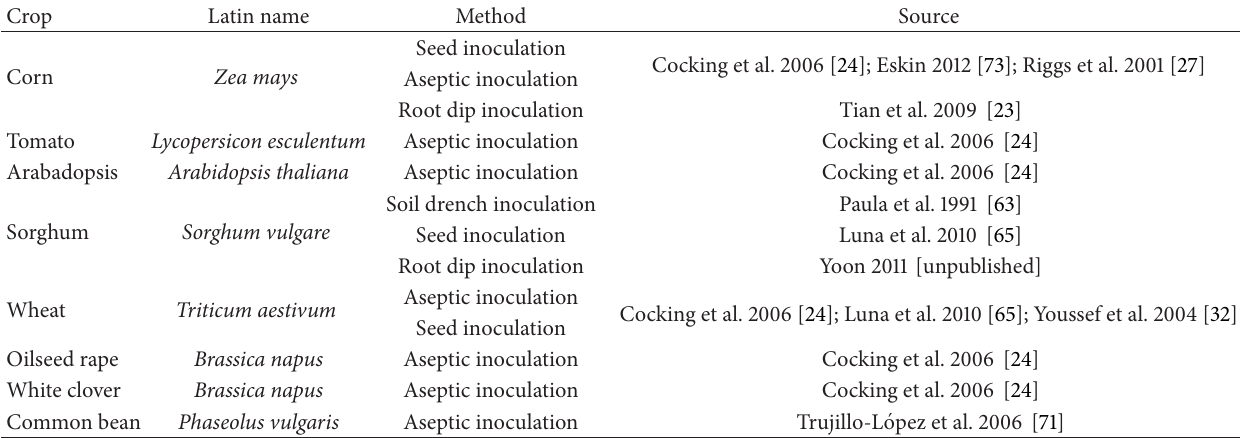
Table 5: Nonnative host plants of Gluconacetobacter diazotrophicus and the methods used for